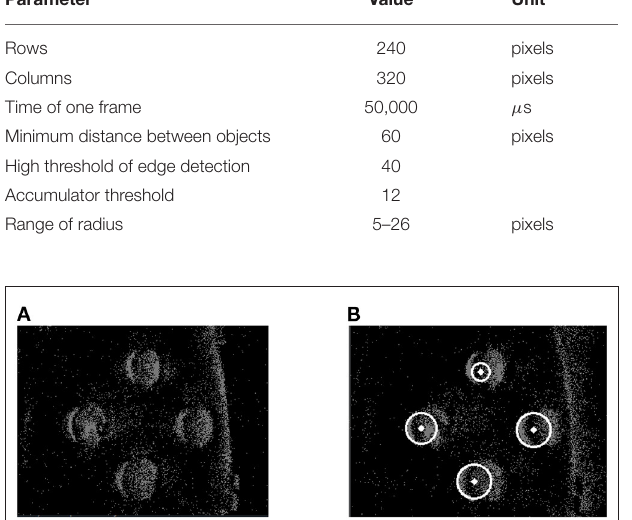
FIGURE 8 | The detection effect of SNN. (A) Raw events of far targets. (B) Detection of far targets. (C) Raw events of near targets. (D) Detection of near